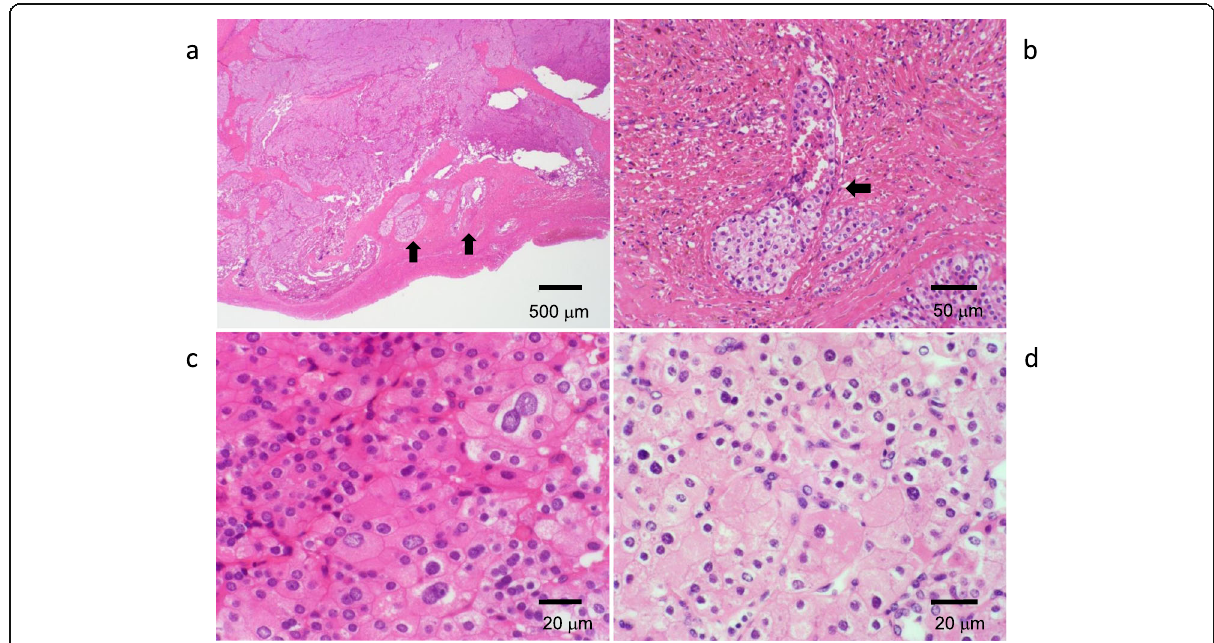
Fig. 1 Histological findings of the parathyroid tumor removed when the patient was 13 years old and the lung metastasis removed when she was 33 years old (hematoxylin and eosin stain). a Capsular invasion of the tumor (arrows). b Vascular invasion of the tumor cells (arrow). c Pleomorphic tumor cells with a large nucleus. d Tumor cells with pleomorphic nuclei showed solid growth, just like the primary